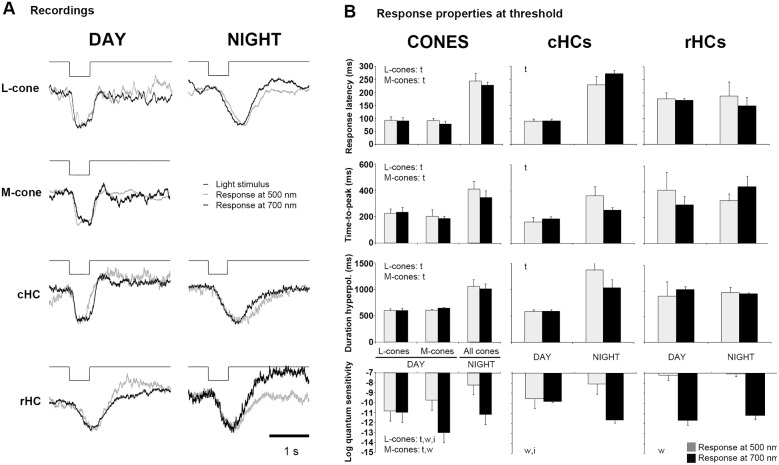
Threshold responses of dark-adapted cones, cHCs and rHCs to 500 nm and 700 nm light stimuli during day and night.(A) Representative examples of dark-adapted cone, cHC and rHC threshold responses (0.5 mV) to a light stimulus (500 ms) at 500 nm (grey trace) and 700 nm (black trace) during the subjective day (left column) and night (right column). The amplitude of each trace has been normalized for better comparison. (B) Averaged response latency, time-to-peak, duration of the hyperpolarization, and quantum sensitivity measured in cones (left column), cHCs (center column) and rHCs (right column) under the conditions described in (A). Data in (B) were analyzed with a two-WAY ANOVA, the first factor was time of day (t) and the second factor was wavelength (w). Significant variations (α = 0.05) are indicated on the left side of each figure; i: w x t interaction.